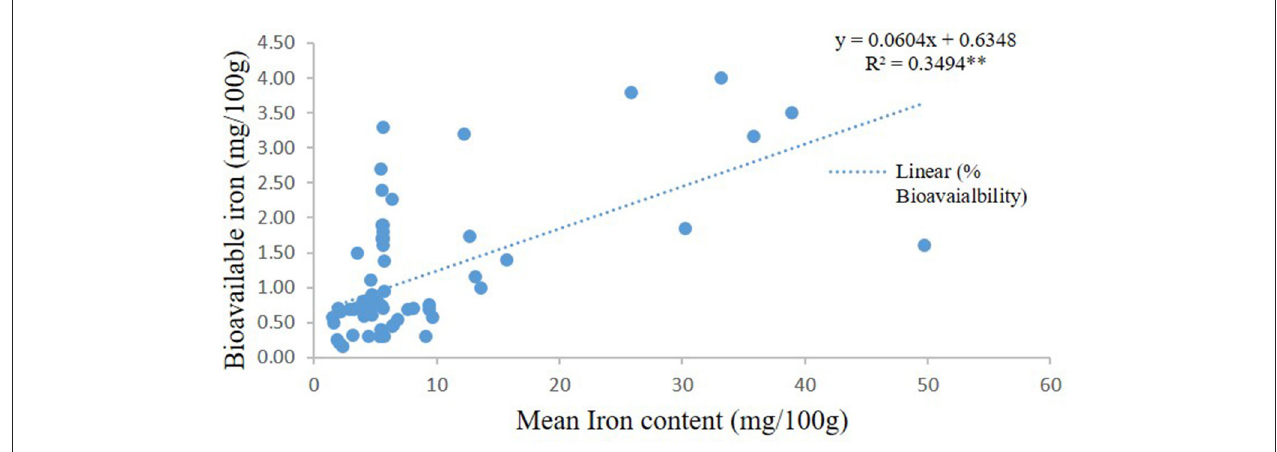
FIGURE 7 | In-vitro bioavailable iron from millets.